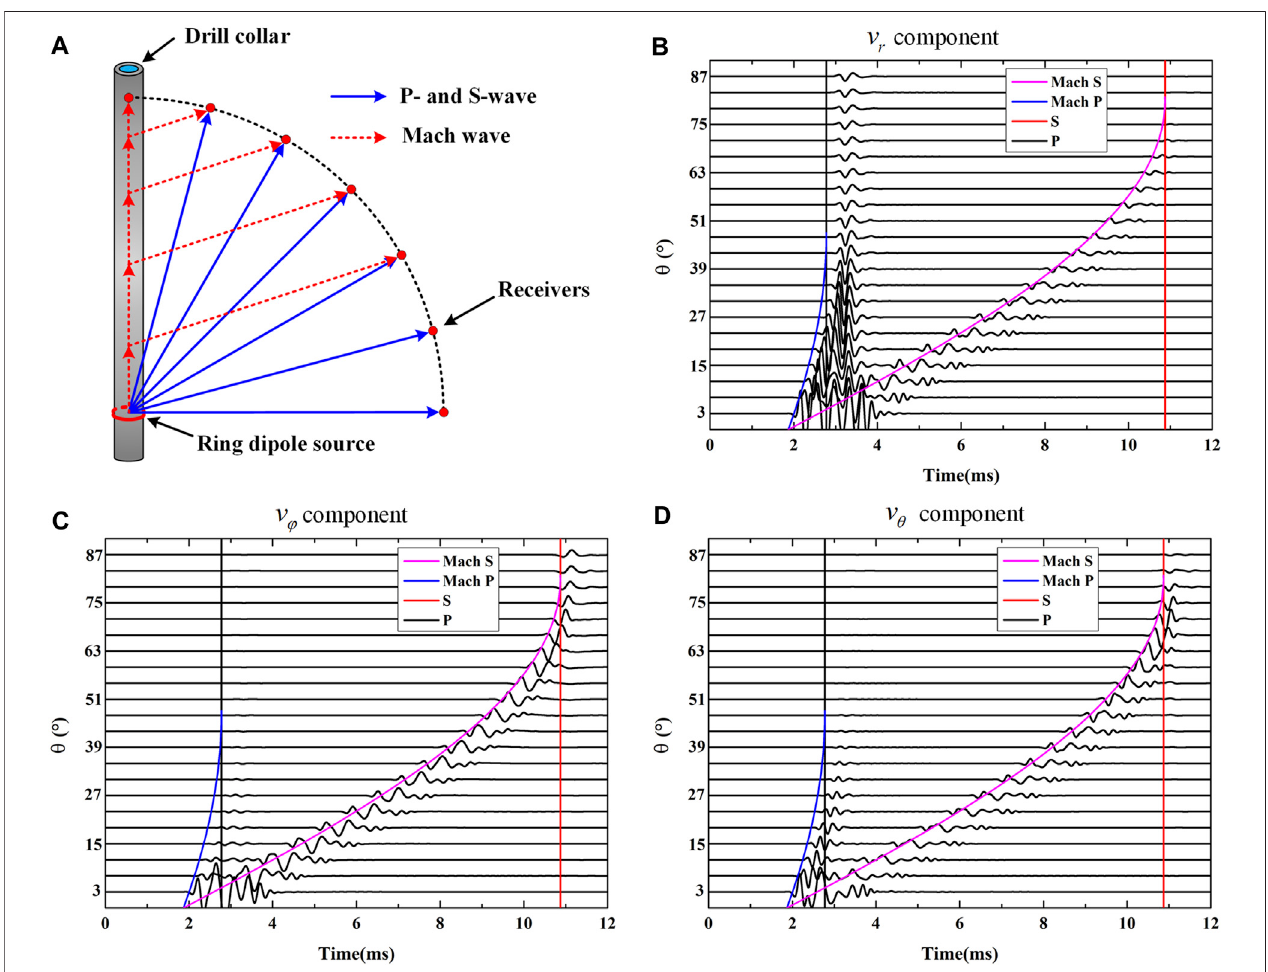
FIGURE 9 | (A) The propagation paths of Mach waves (red dot lines) and P-, S-waves radiated from the source directly (blue solid lines). (B) The v r component received on blue circle (see Figure 6 ). (C) The v φ component received on green circle (see Figure 6 ). (D) The v θ component received on blue circle (see Figure 6 ). The black, red, blue and magenta lines in (B) , (C) and (D) denote the theoretical arrival times of P-, S-, Mach P- and Mach S-waves, respectively.